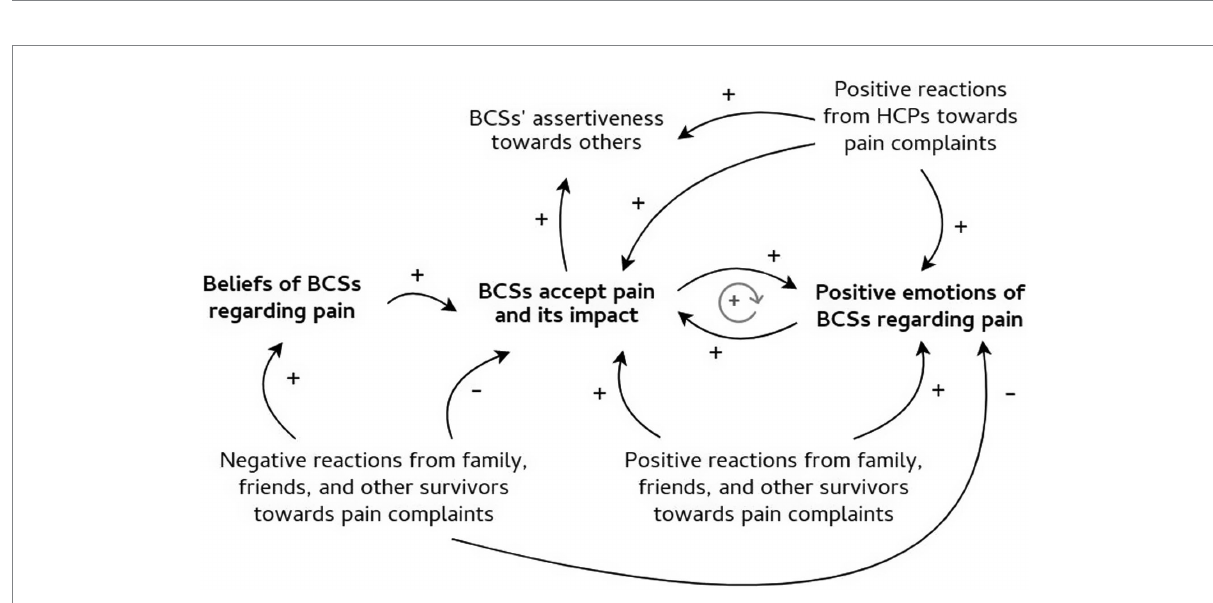
FIGURE 3 Accepting pain and influencing processes. Figure shows the pattern of accepting pain and its influencing processes on an intrapersonal, interpersonal, and societal level. The intrapersonal processes are shown in bold. The influencing relationships between processes were translated into words-and-arrows diagrams. The positive arrows represent relationships that reinforce the acceptance of pain, whilst the negative arrows stand for inhibiting influences. When a relationship is reciprocal, a circular arrow in grey was added. The following abbreviations were used: BCS, breast cancer survivor; HCP, healthcare